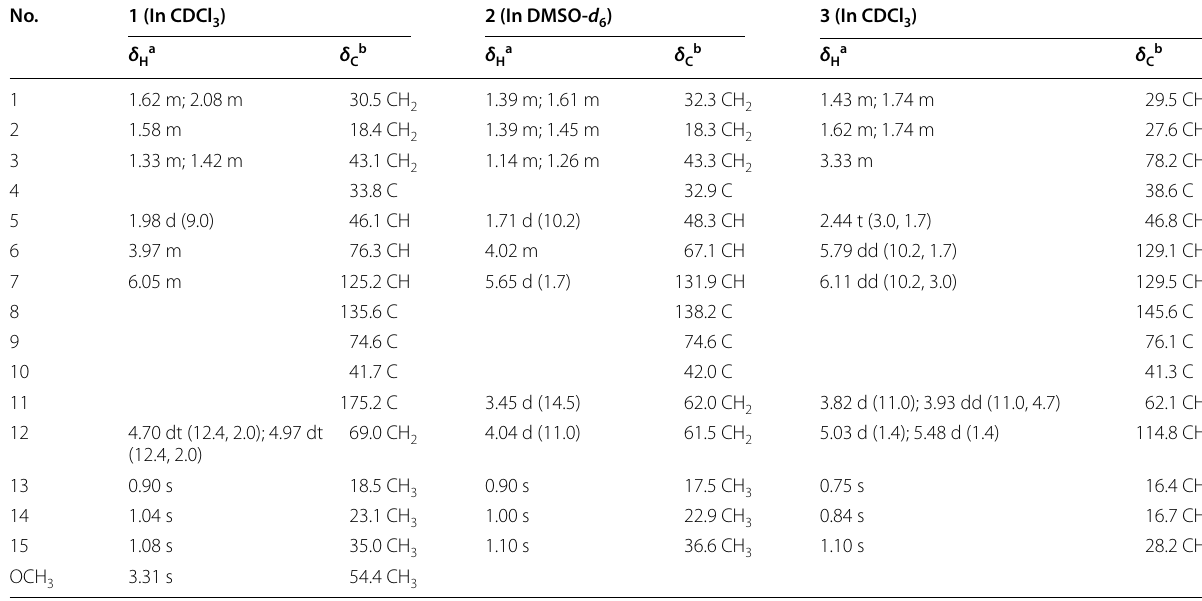
Table 1 NMR data of 1 – 3 ( δ in ppm, J in Hz)